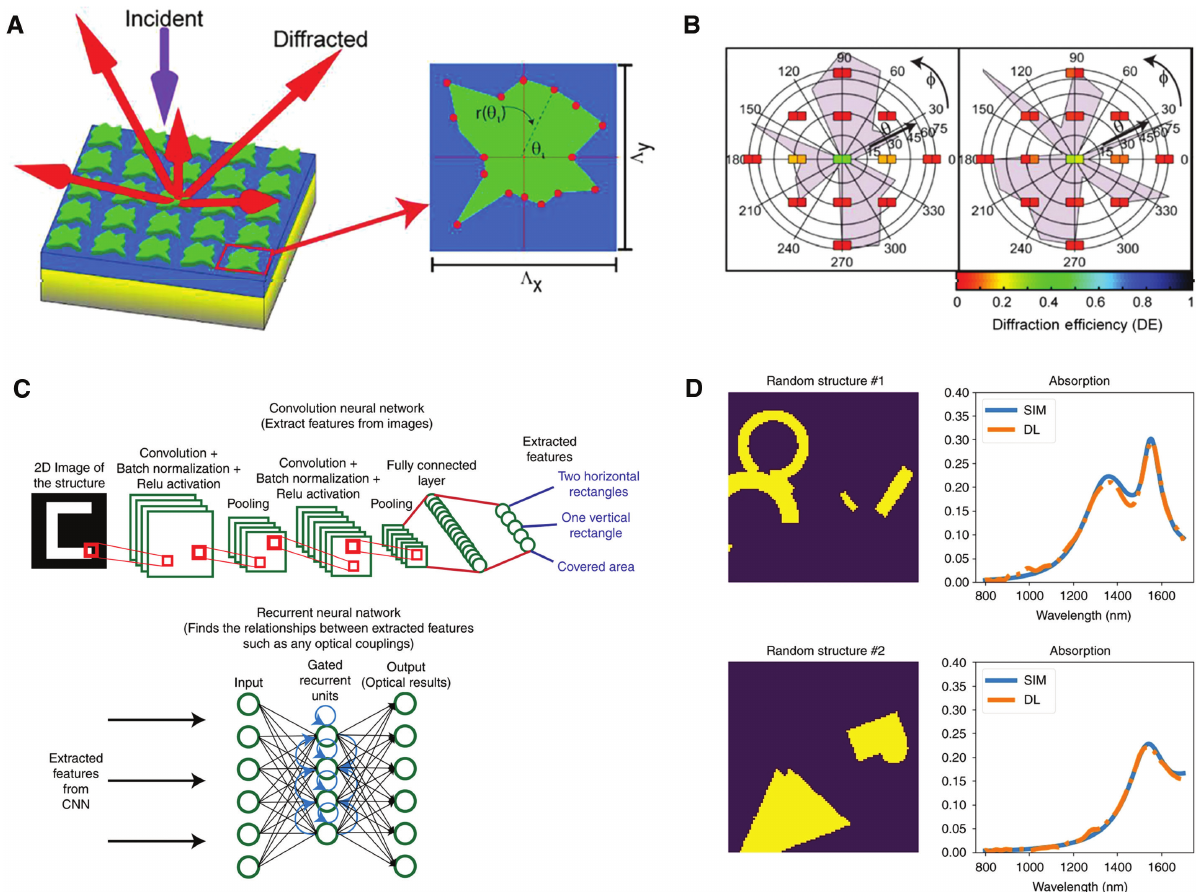
Figure 2: Image-based forward modelling via DL. (A) A schematic of a metagrating antenna with arbitrary shape. A sixteen-sided polygon is defined by 16 radius coordinates of the corresponding vertices. (B) Examples of the prediction results. In each panel, the background grey images display the shapes of metagrating, whereas the double square boxes correspond to target (left) and predicted (right) diffraction efficiency at each diffraction angle. (C) A network structure combined with CNN and RNN. A CNN is used to extract important features from the 2D images, and an RNN is used to find the correlations in the data. (D) Examples of the results. 2D images (lefts) are fed as inputs, and the network provides absorption spectra (rights) as outputs. (A) and (B) are adapted with permission from Ref. [55] and (C) and (D) are reprinted with permission from Ref. [54] (CC BY